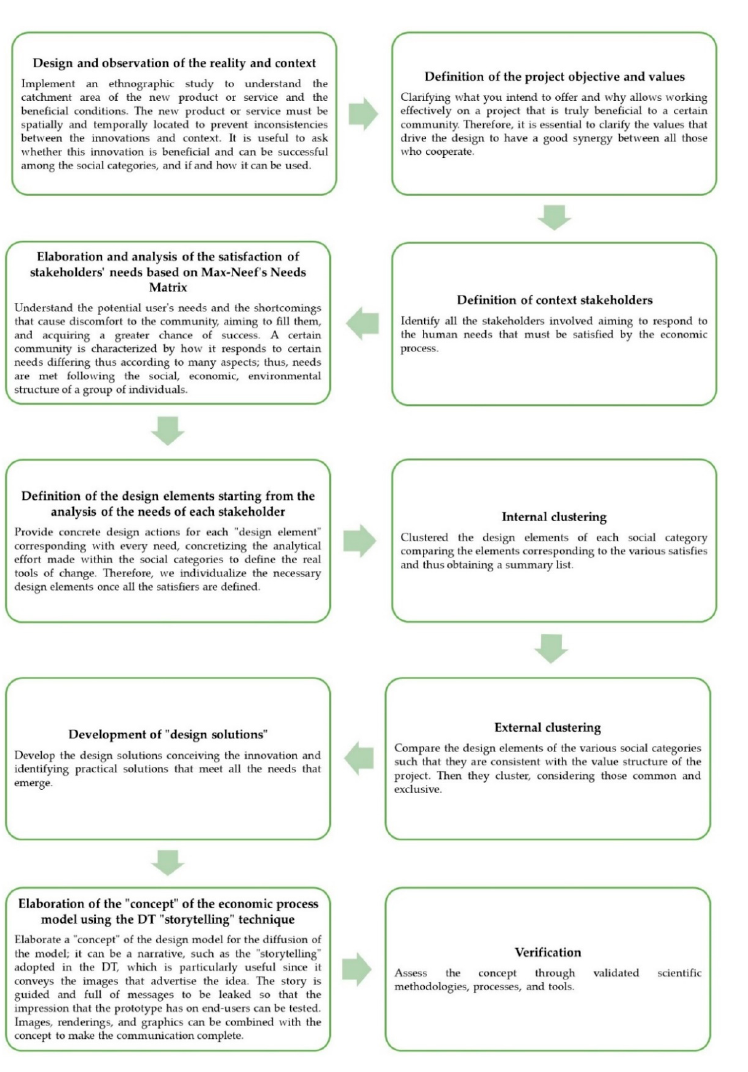
Figure 1. Design